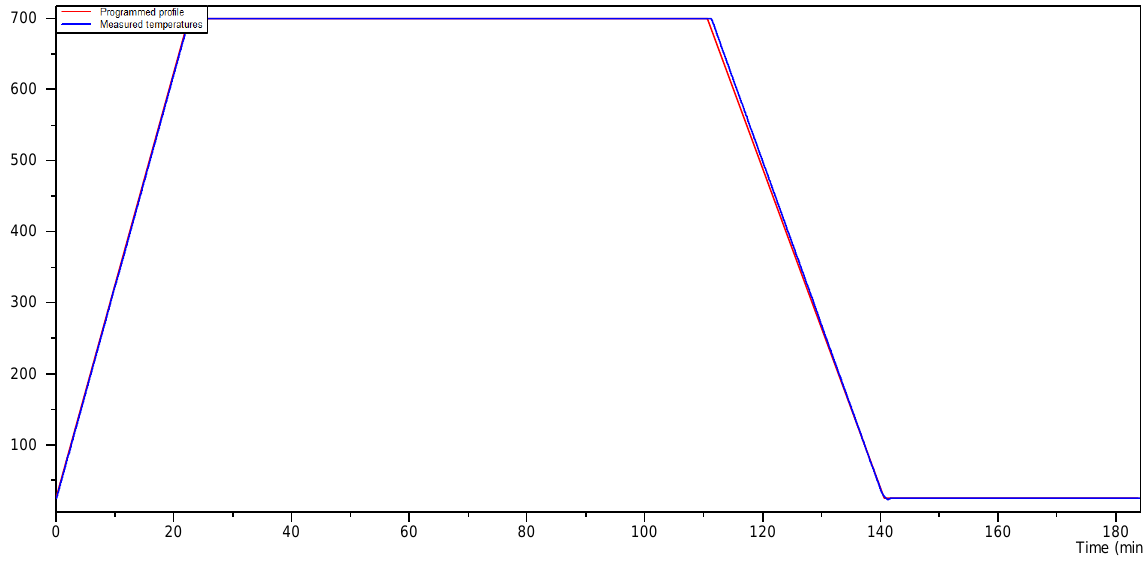
Figure 3. The cast iron microstructure for sample 3 with precipitation of graphite and molybdenum carbide. Magnification 500× ( a ), 1000× ( b ), 1500× ( c ).